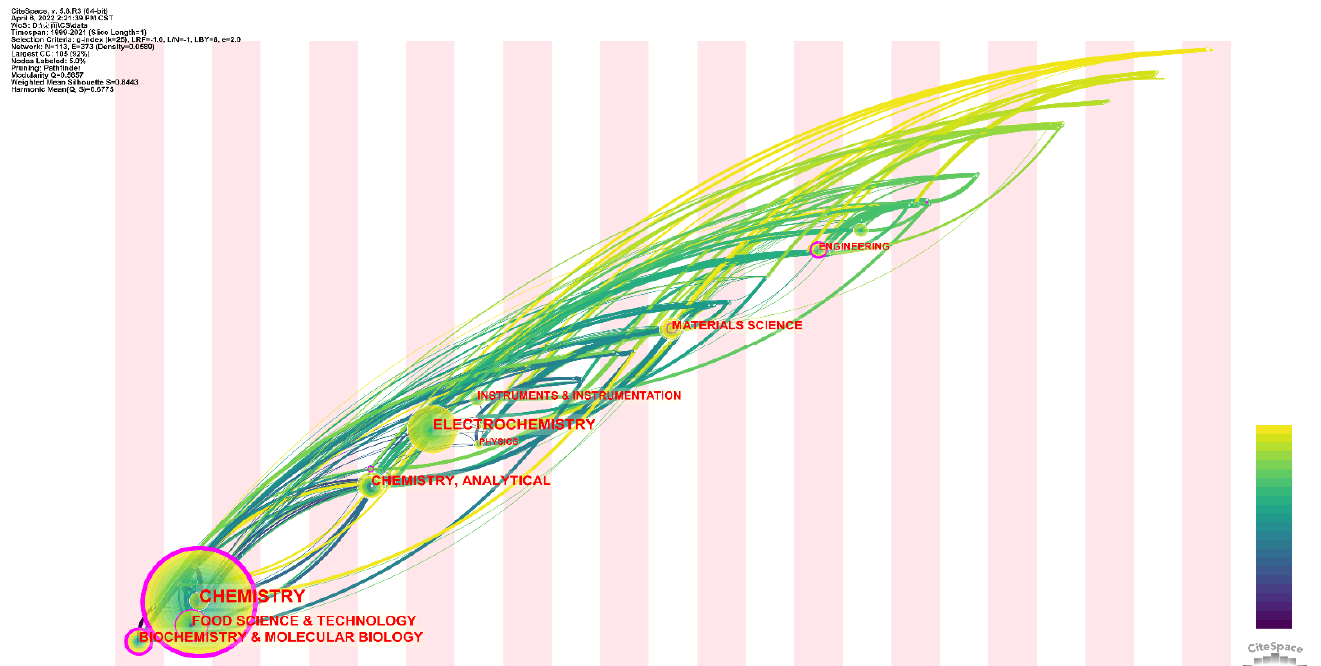
Figure 4. Time-zone view of research categories for the evaluation of antioxidants using electrochemical sensors.